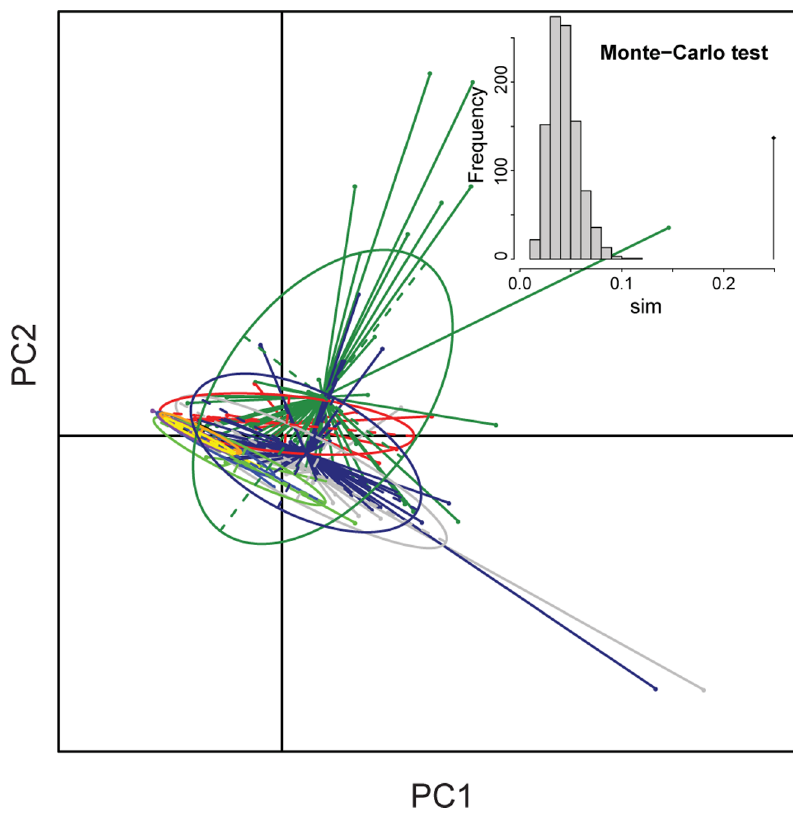
Figure 5. PCA plot portraying hydraulic strategies among all the studied communities. Between-Class principal component analysis shows the ellipses and gravity centers. This plot is based on only hydraulic traits ( F , S and K s ). The insert in the upper right corner is the histogram of 1000 simulated values for the between-groups PCA and the observed value (vertical line at sim=0.25). Sim = ratio of between class and total inertia. Red=Olmos paleoforest, dark green = tropical rain forest, light green = hardwood forest, light yellow = sage scrub, dark yellow= palm forest, light blue = desert, dark blue= dry deciduous forest, grey = montane forest, black= juniper mesquite savanna, purple= mesquite savanna.